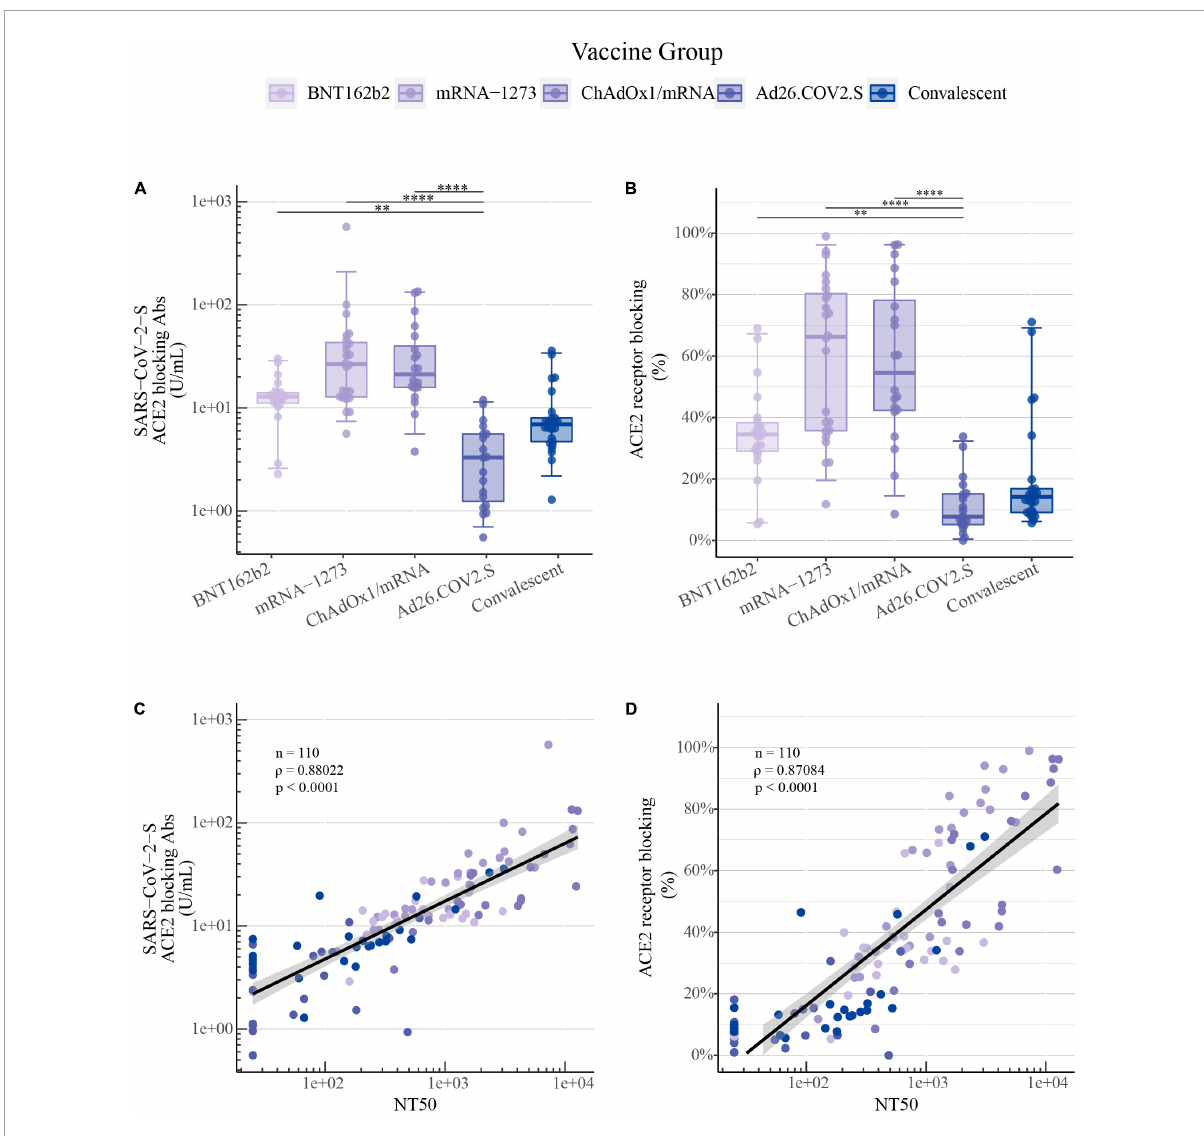
FIGURE3 ACE2 competition assay as a surrogate for quantifying COVID-19 vaccine-induced antibody neutralization capacity: (A) SARS-CoV-2-S ACE2 receptor-blocking antibodies in U/mL and (B) ACE2 receptor blocking in percentage for SARS-CoV-2-S wt induced by primary COVID-19 vaccination with BNT162b2 ( n = 22), mRNA-1273 ( n = 24), ChAdOx1/mRNA ( n = 20) or Ad26.COV2.S ( n = 19) quantified by the MSD platform (serum 1:100). Data from convalescent comparators ( n = 25) are also displayed, but are not included in the statistical analysis. The boxplots present the lower quartile, median and upper quartile, and the error bars indicate 95% CI. P -values were indicated as follows: ** p < 0.01 and **** p < 0.0001. (C) Spearman’s correlation between SARS-CoV-2-S wt NT50 values quantified by the pseudovirus neutralization assay and ACE2 receptor-blocking antibodies in U/mL and (D) ACE2 receptor blocking in percentage quantified by the MSD ACE2 competition